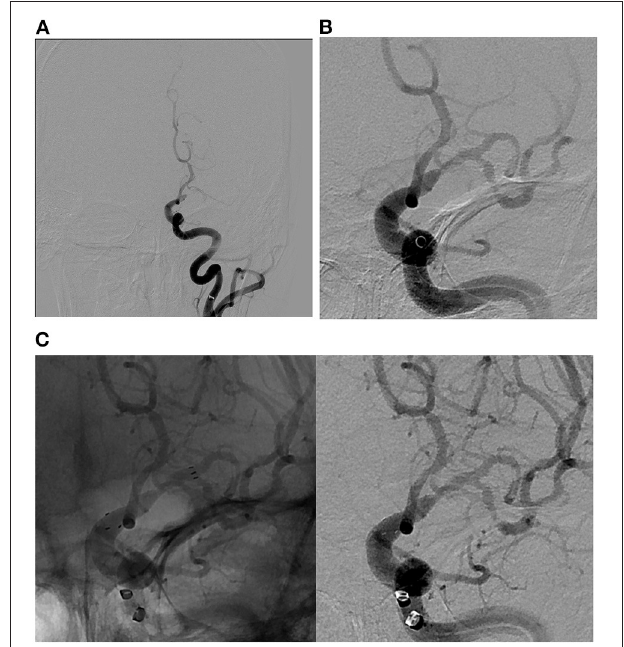
FIGURE 3 | Illustrative case of ICAS-related LVO in the M1 segment of the left middle cerebral artery. (A) Pre-MT angiographic image demonstrating complete occlusion of M1 segment of the left middle cerebral artery. (B) Post-MT angiographic image demonstrating partial recanalization of M1 segment of the left middle cerebral artery with persistent severe flow-limiting stenosis. Of note, ADAPT technique was used in this case. (C) Native (left) and digitally subtracted (right) angiographic images demonstrating successful intracranial stenting with Neuro-Form atlas stent as a rescue therapy with a goal of maintaining cerebral flow through the stenotic portion of M1 segment of the left middle cerebral artery. ADAPT, direct aspiration first pass technique; MT, mechanical thrombectomy; ICAS, intracranial atherosclerosis; ELVO, Emergent large vessel